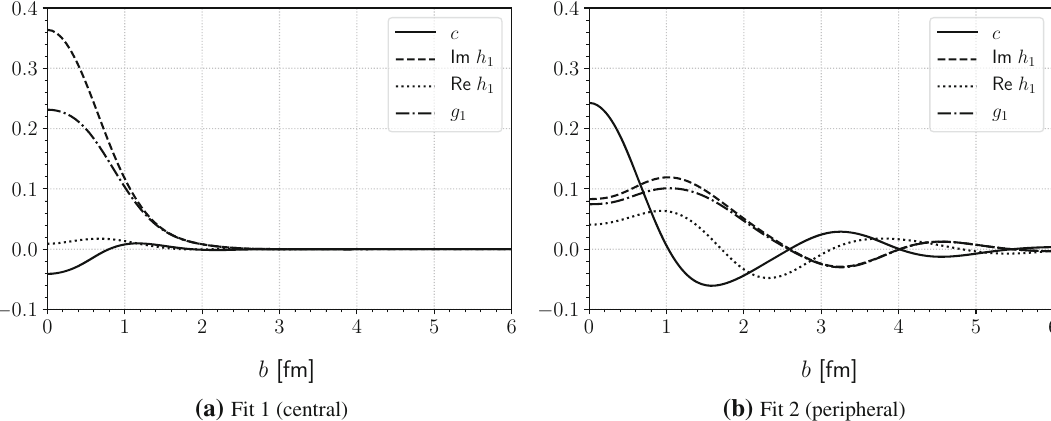
Fig. 6 Function c ( s , b ) and several other functions characterizing pp collisions in dependence on impact parameter at the energy of 52.8 GeV corresponding to the central and peripheral fits